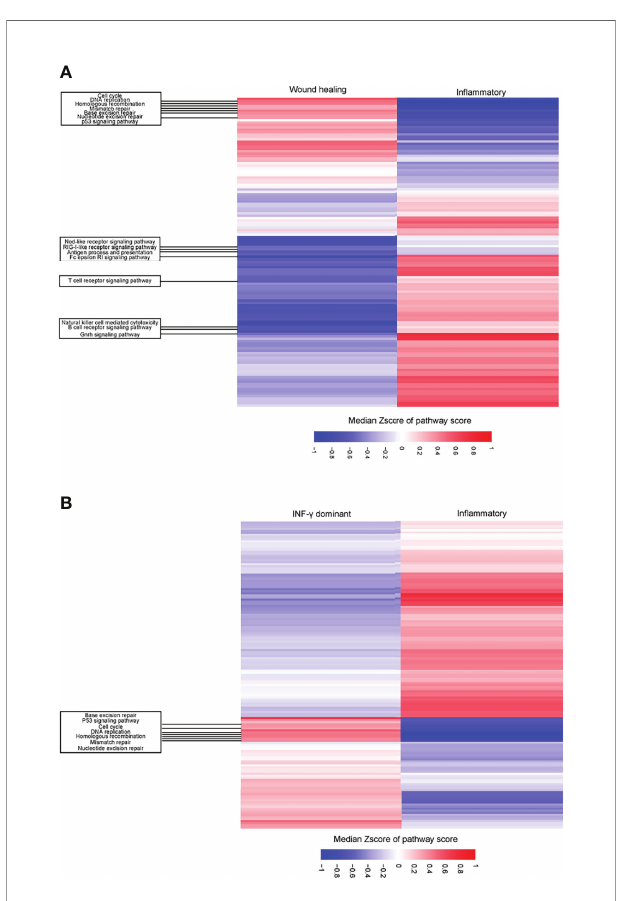
FIGURE 7 | Differential expression of pathways between C1 (wound healing)/ C2 (IFN- g dominant) vs. C3 (in fl ammatory) immune subtypes in LUAD patients. (A) Heatmap showing the different upregulation of gene set enrichment analysis (ssGSEA) of KEGG pathways among the C1 (wound healing) and C3 (in fl ammatory) immune subtypes in the TCGA LUAD cohort. (B) Heatmap showing the different upregulation of gene set mRNA enrichment analysis (ssGSEA) of KEGG pathways among the C2 (IFN- g dominant) and C3 (in fl ammatory) immune subtypes in the TCGA LUAD cohort. The result is expressed according to the median z-scores of the ssGSEA score of